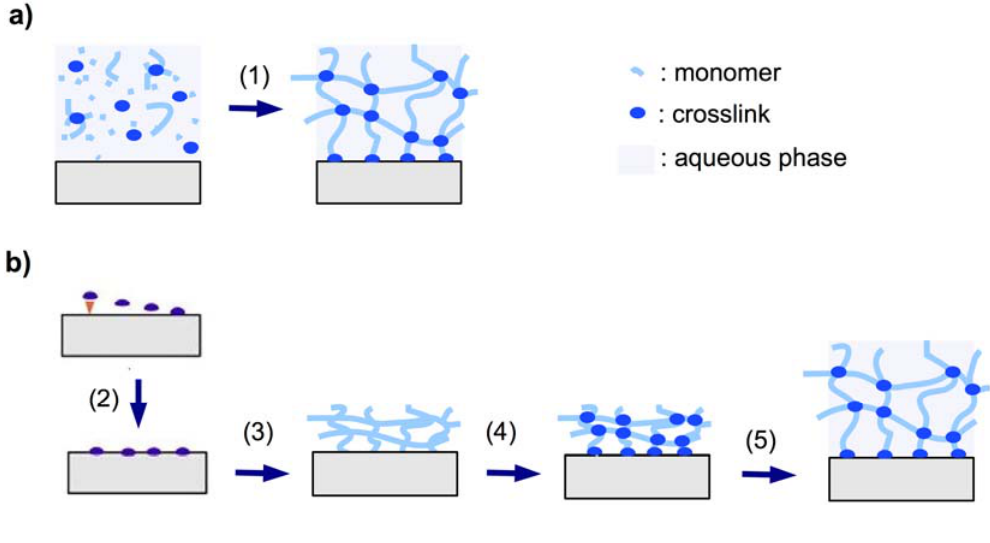
Figure 2. Schematic representation of ( a ) in situ crosslinking polymerization (1) and surface attachment of the hydrogel in the swollen state, and ( b ) post-synthetic crosslinking by first immobilizing an adhesion-promoting molecule (2), followed by deposition of a prepolymer (3), crosslinking of the dry layer (4), and subsequent swelling of the gel